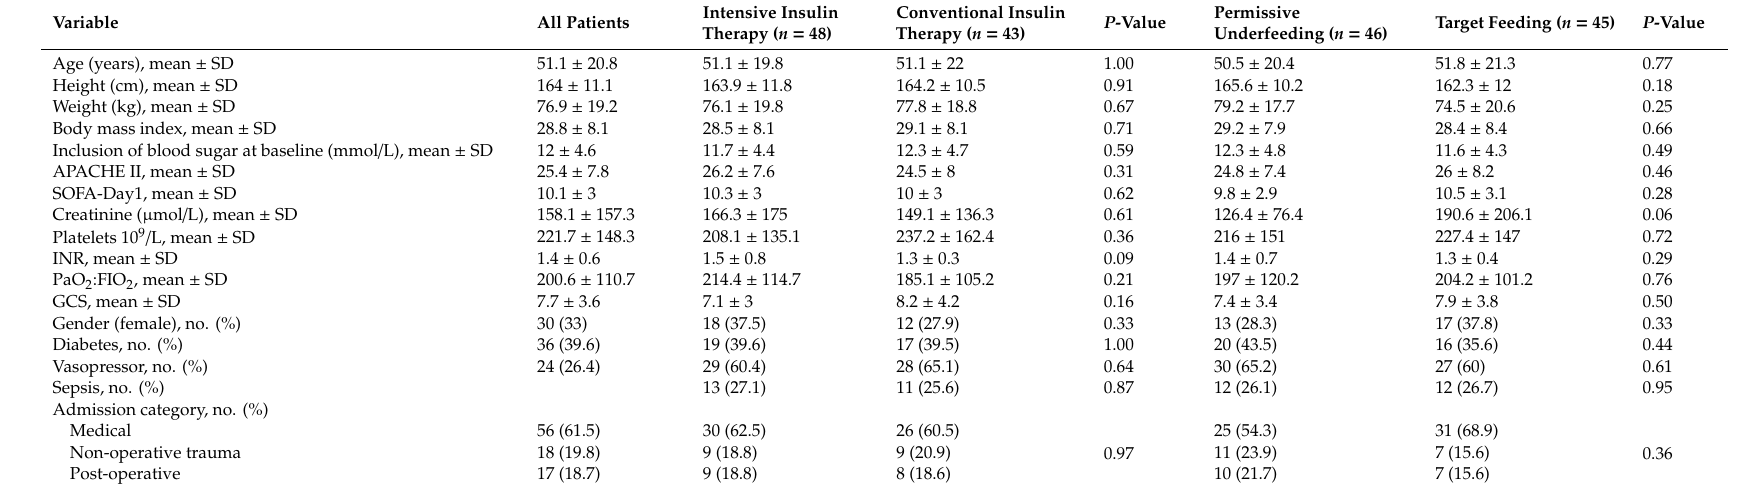
Table 1. Baseline characteristics of all patients and by randomization